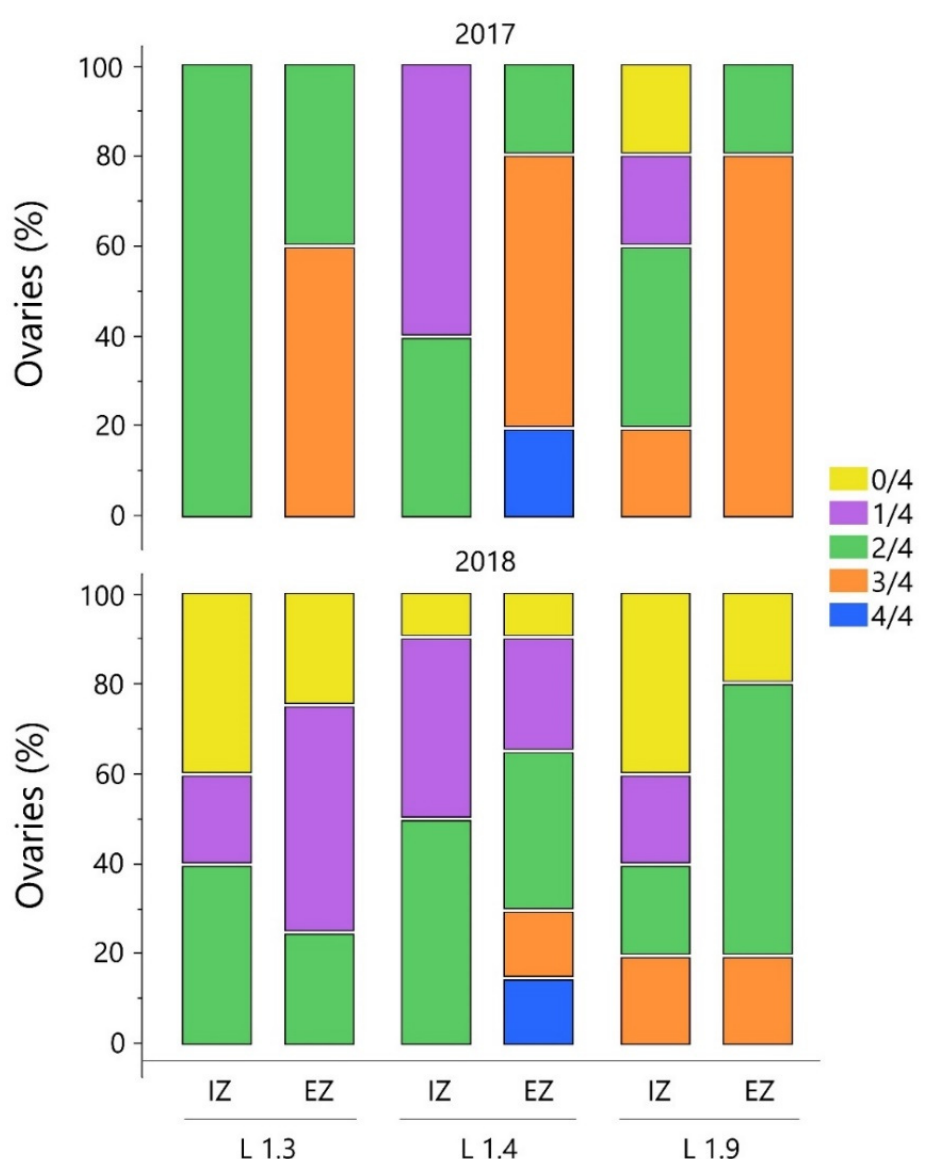
Figure 4. Percentage distribution of ovaries with four (4/4), three (3/4), two (2/4), one (1/4) and zero (0/4) developed ovules for pistils sampled from the internal (IZ) and external zone (EZ) of the canopy. Data refer to the 2017 and 2018 spring seasons for three Leccino olive clones (L 1.3, L 1.4, L 1.9). Ovaries with 3/4 fully developed ovules (Figure 3B) were more frequent in flowers of EZ inflorescences (between 60.4 and 80.2%) than in IZ ones (only found in 20.3% of ovaries in the L 1.9 clone). In 2018 a generalized poor ovary performance was observed, and the 3/4 proportion was only recognized in 15.2–20.3% of analyzed samples of L 1.9 and L 1.4 (Figure 4). Ovaries without functional ovules (0/4) were found in a range of 10.4–40.2%, with the highest values associated with the inner position, regardless of clone. As a general trend, pistils of perfect flowers from IZ inflorescences showed lower ovary quality rates (1/4–2/4), an occurrence that could make it difficult to achieve a regular fertilization (Figure 4). Considering that ovaries with three or four fully developed ovules have a good potential for fertilization and fruit formation, these two ovule categories were grouped for a two-way ANOVA analysis (Table